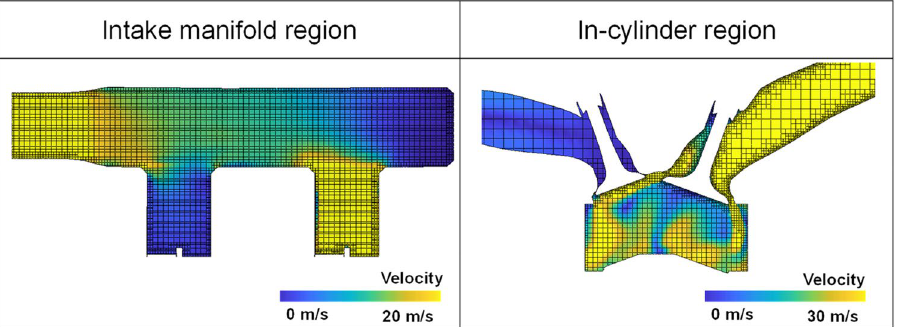
Figure 4. Cut-plane of computational cells at bTDC 300°.